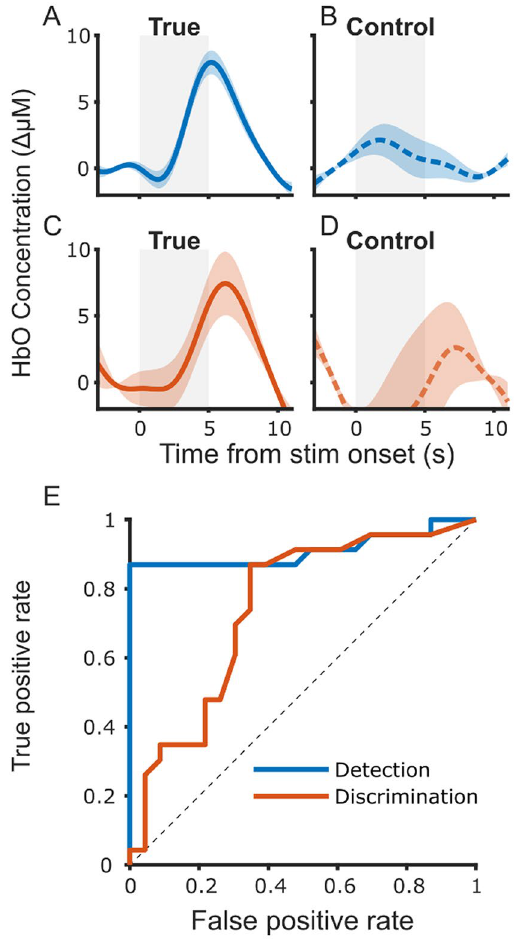
Figure 8. Individual infant detection and discrimination analysis. ( A,B ) Show examples from one participant SD011 of detection responses averaged across all channels and conditions for true ( A ) and control ( B ) stimulus blocks (shaded areas are 1 SEM). ( C,D ) Show the true and control discrimination responses respectively. ( E ) Shows the ROC curve, calculated across all 23 participants, for detection and discrimination response discovery